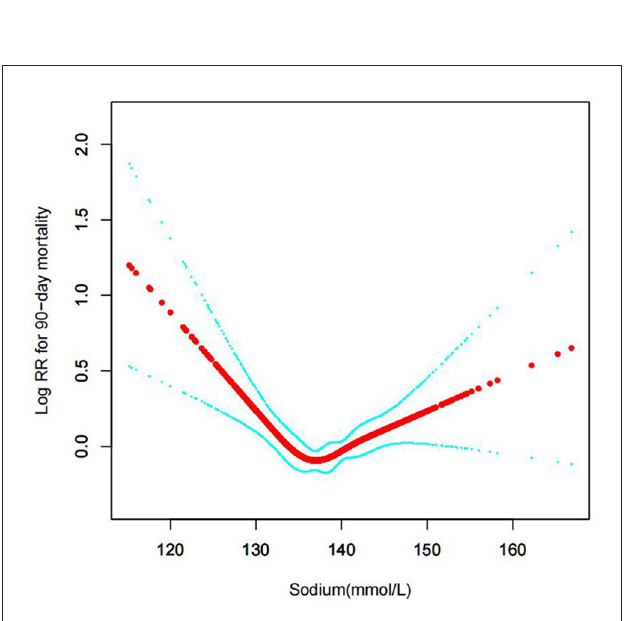
FIGURE10 Association between serum sodium levels and 4-year all-cause mortality (After adjustment for other covariates). A generalized additive model (GAM) revealed a threshold, non-linear relationship between serum sodium levels and 4-year all-cause death. U-shaped relationships were observed after adjustment for other covariates by spline smoothing plot. The smooth curve fit between variables is shown by a solid rad line. The 95% confidence interval from the fit is represented by imaginary blue